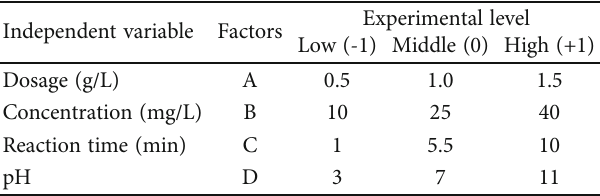
Table 1: Independent variables and experimental level in this study.